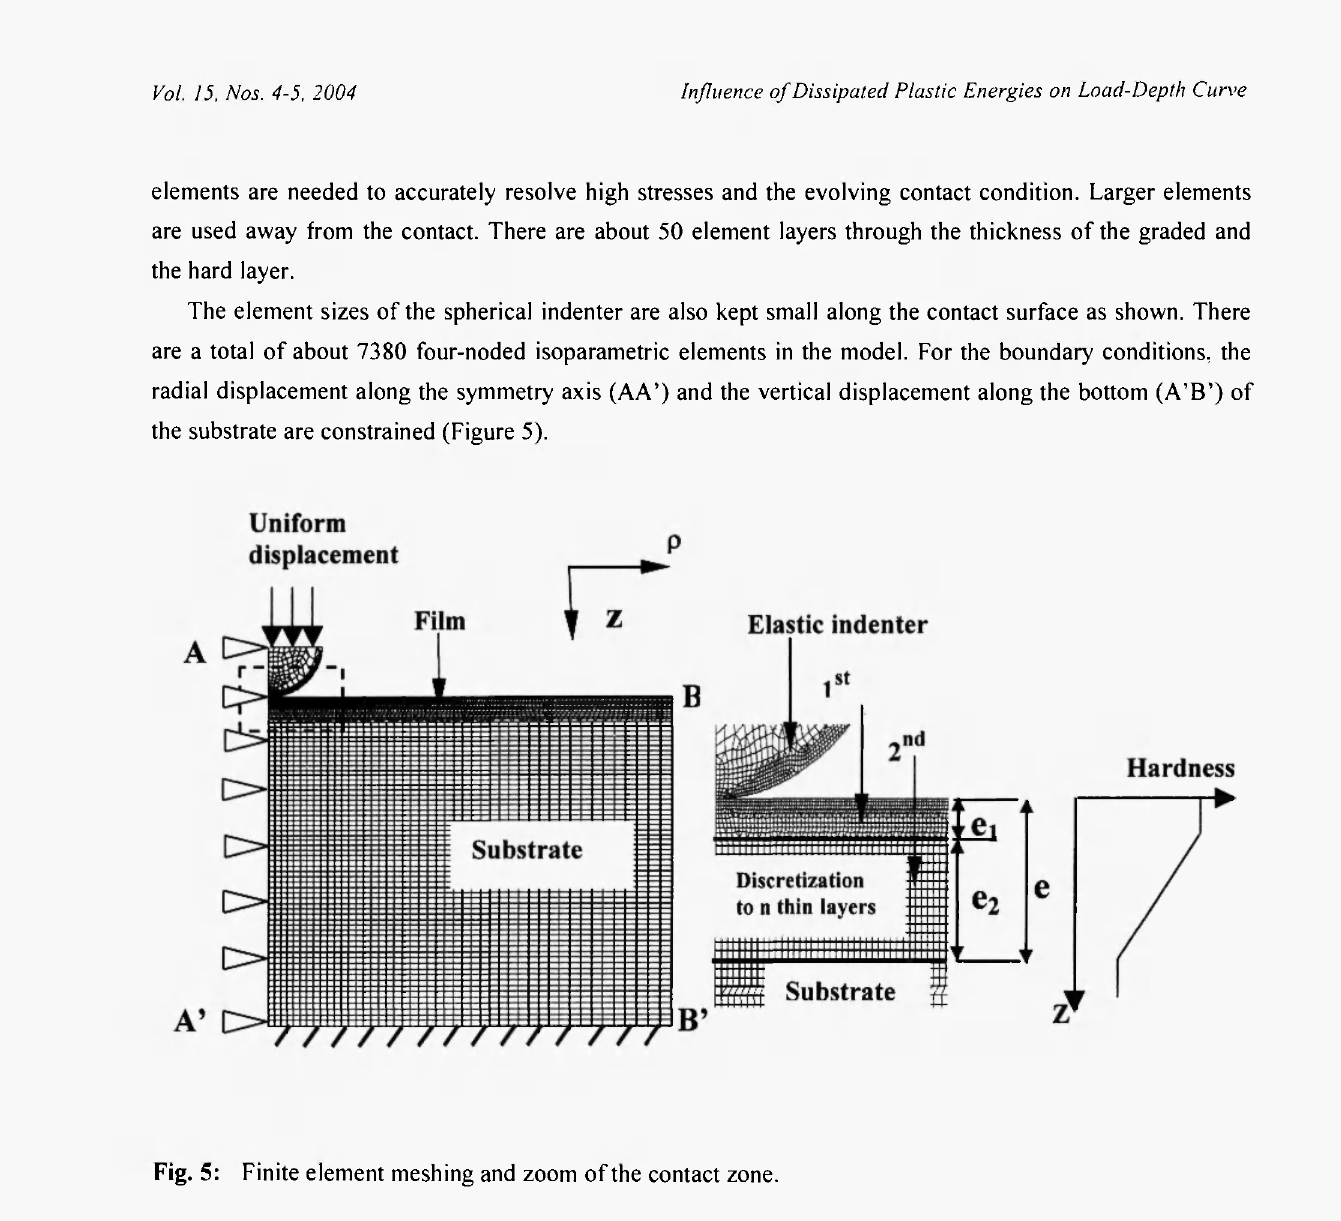
Fig. 5: Finite element meshing and zoom of the contact